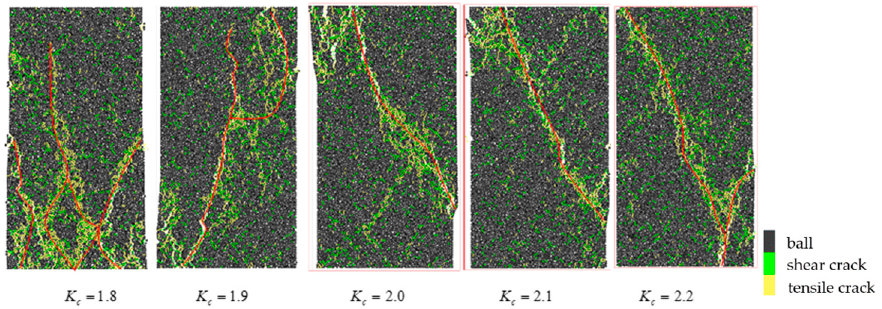
Figure 9. Failure mode of rock with different tensile-shear bond strength ratios.